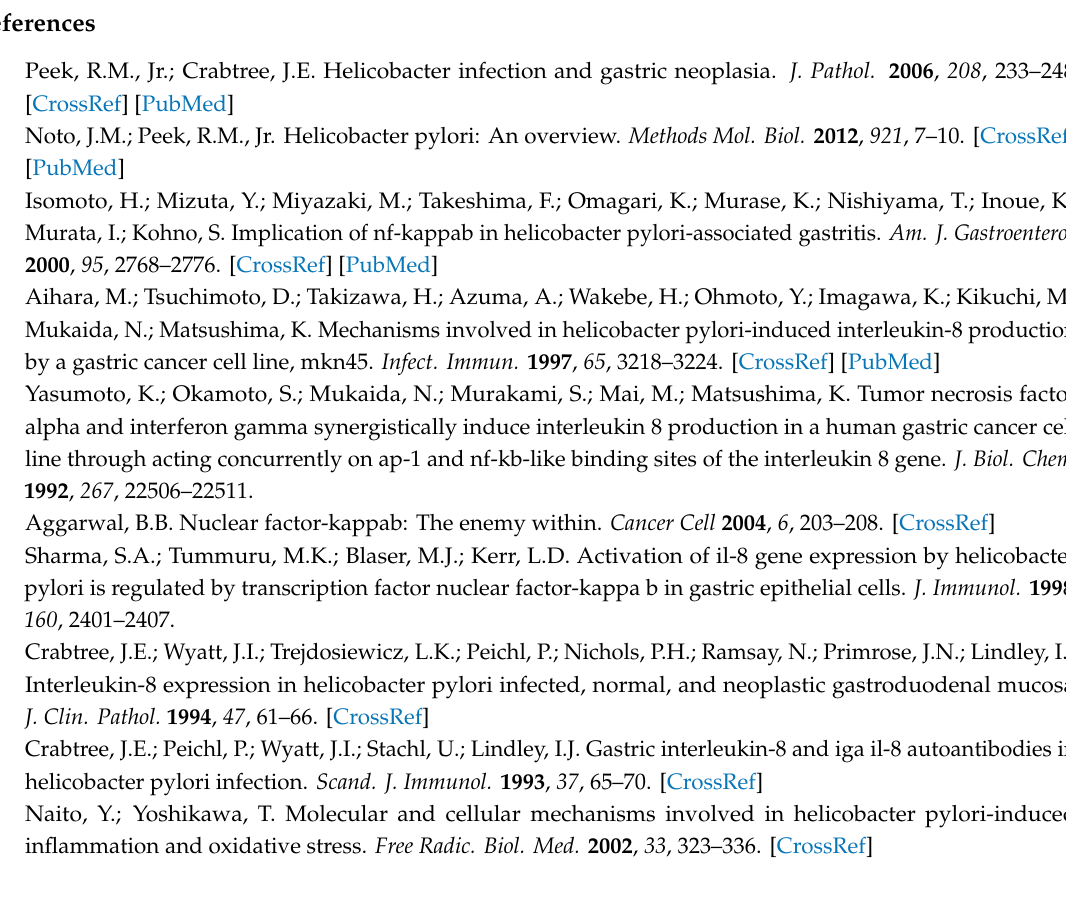
Figure S1: E ff ect of the extracts on the NF- κ B driven transcription in AGS cells. Data are expressed as percentage versus the stimulated control, which is arbitrarily assigned the value 100%., Figure S2: E ff ect of the extracts on the NF- κ B driven transcription in GES-1 cells. Data are expressed as percentage versus the stimulated control, which is arbitrarily assigned the value 100%, Figure S3: E ff ect of the extracts on the IL-8 release in AGS cells. Data are expressed as percentage versus the stimulated control, which is arbitrarily assigned the value 100%, Figure S4: E ff ect of the extracts on the IL-8 release in GES-1 cells. Data are expressed as percentage versus the stimulated control, which is arbitrarily assigned the value 100%, Figure S5: E ff ect of the extracts on the IL-8 promoter activity in AGS cells. Data are expressed as percentage versus the stimulated control, which is arbitrarily assigned the value 100%, Figure S6: E ff ect of the extracts on the IL-8 promoter activity in GES-1 cells. Data are expressed as percentage versus the stimulated control, which is arbitrarily assigned the value 100%, Figure S7: E ff ect of the extracts on the IL-6 release in GES-1 cells. Data are expressed as percentage versus the stimulated control, which is arbitrarily assigned the value 100%, Table S1: List of the primers used in the